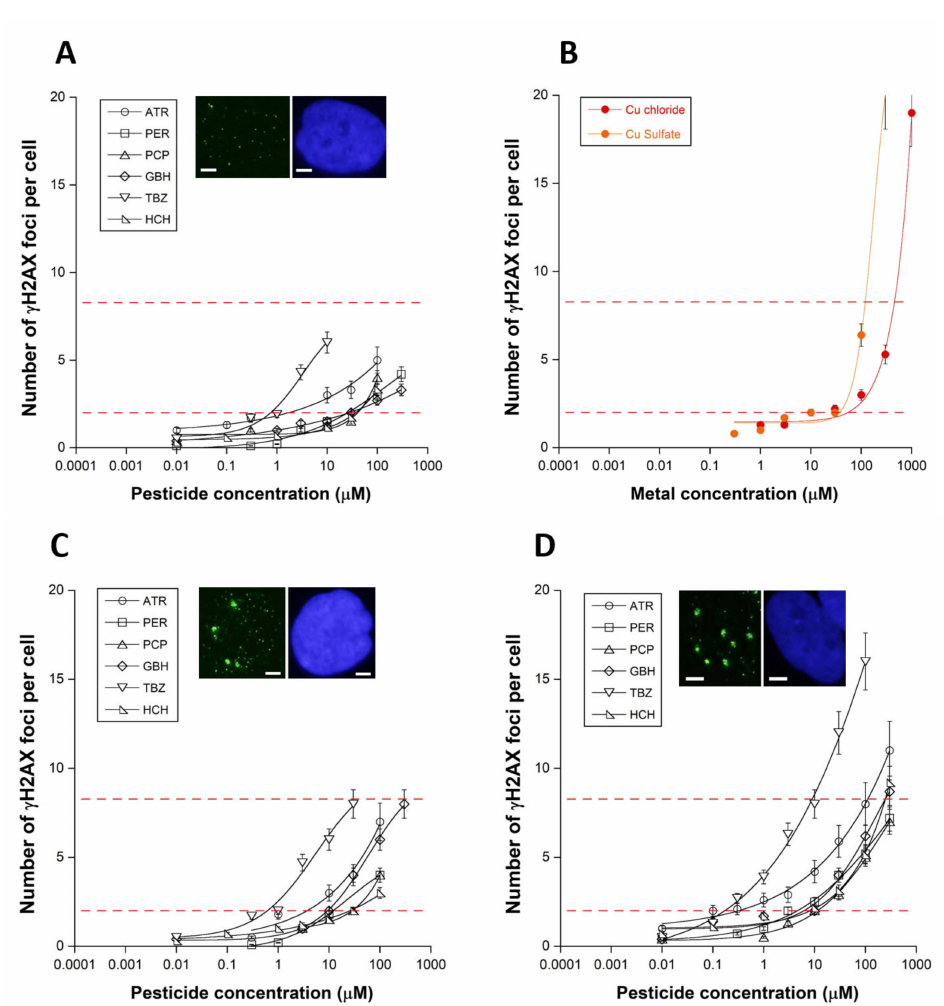
Figure 1. Unrepaired DSB after exposure to pesticides and metal. Number of γ H2AX foci per cell in the human untransformed radioresistant 1BR3 cells after incubation for 24 h with the indicated pesticide ( A ) or with CuSO 4 and CuCl 2 solutions ( B ). Number of γ H2AX foci per cell in the human untransformed radioresistant 149BR ( C ) and delayed-RIANS 8HNG ( D ) cells after incubation for 24 h with the indicated pesticide. Each plot represents the mean ± standard error (SEM) of four replicates. Dotted lines represent the induction of the induction of two or eight γ H2AX foci per cell Inserts: Representative examples of γ H2AX and DAPI-counterstained images obtained with 1 µ M PER ( A ), 3 µ M TBZ ( C ) and 100 µ M ATR ( D ). White bar represents 5 µ